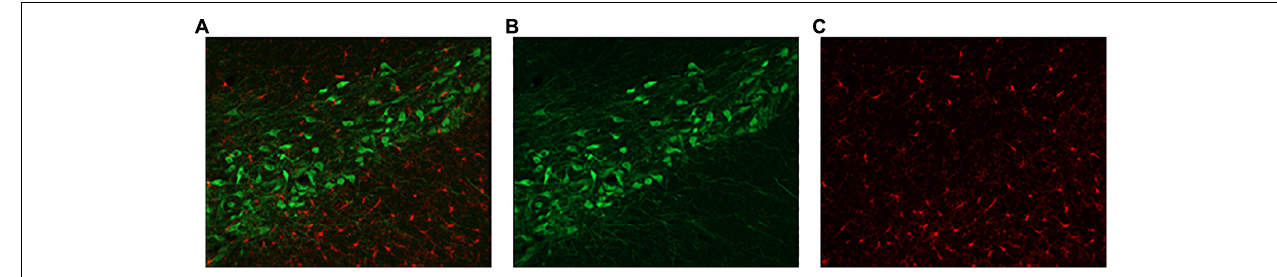
FIGURE 2 | Representative substantia nigra sections. (A) Double-labelled sections of interest were assessed for (B) TH-(green) and (C) Iba1-positive cells (red).